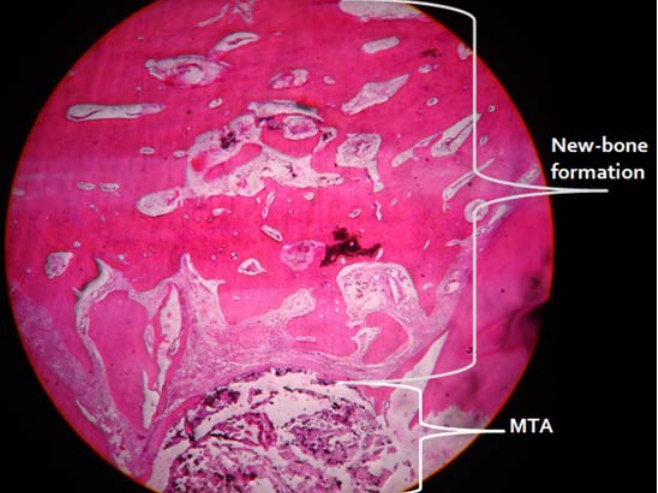
FIGURE 4 – Furcation treated with MTA. New-bone